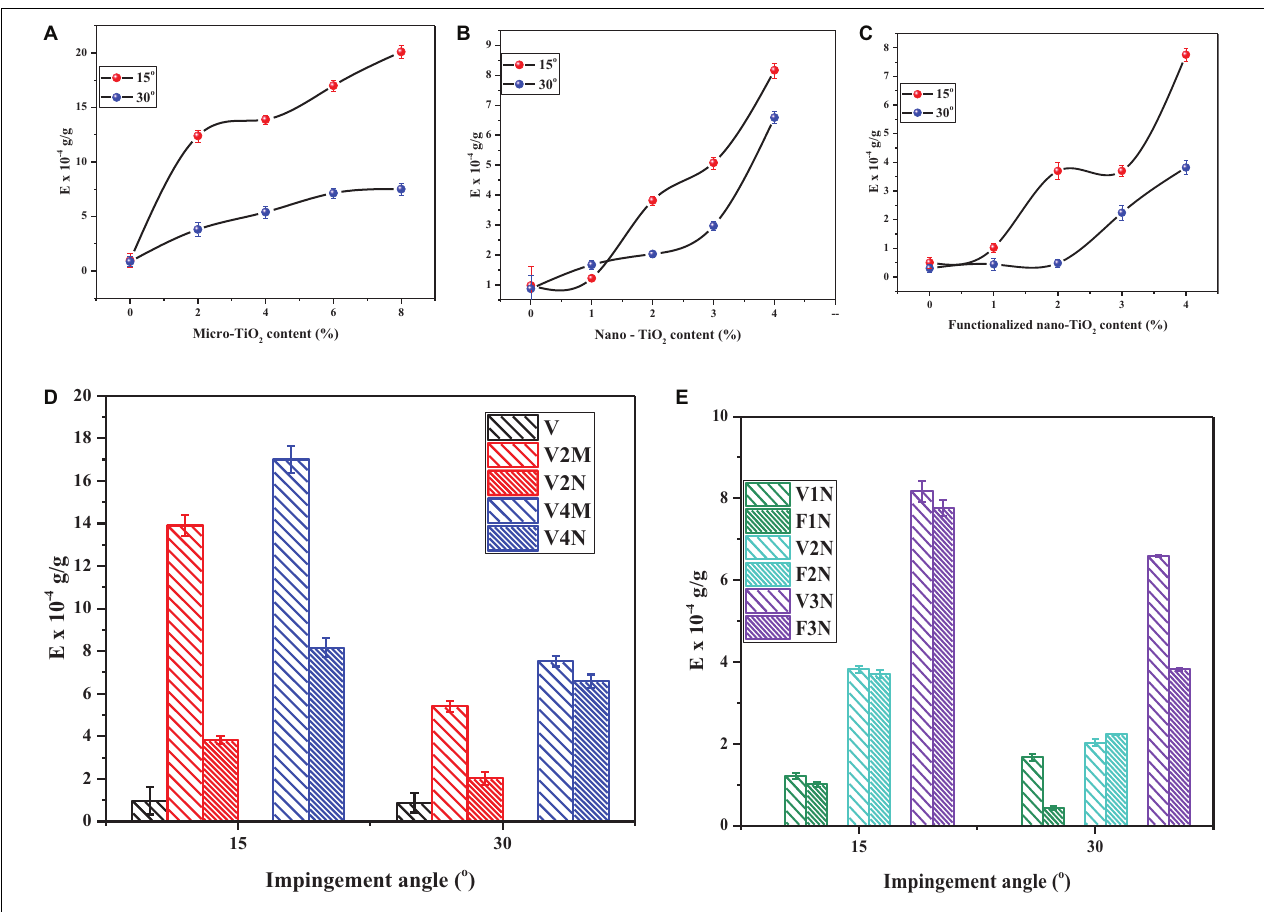
FIGURE 11 | Erosion as a function of amount of particles for two angles; (A) microcomposites (MCs), (B) nanocomposites (NCs), and (C) functionalized nanocomposites (F-NCs); comparative erosion performance for (D) MCs and NCs, and (E) NCs and F-NCs.